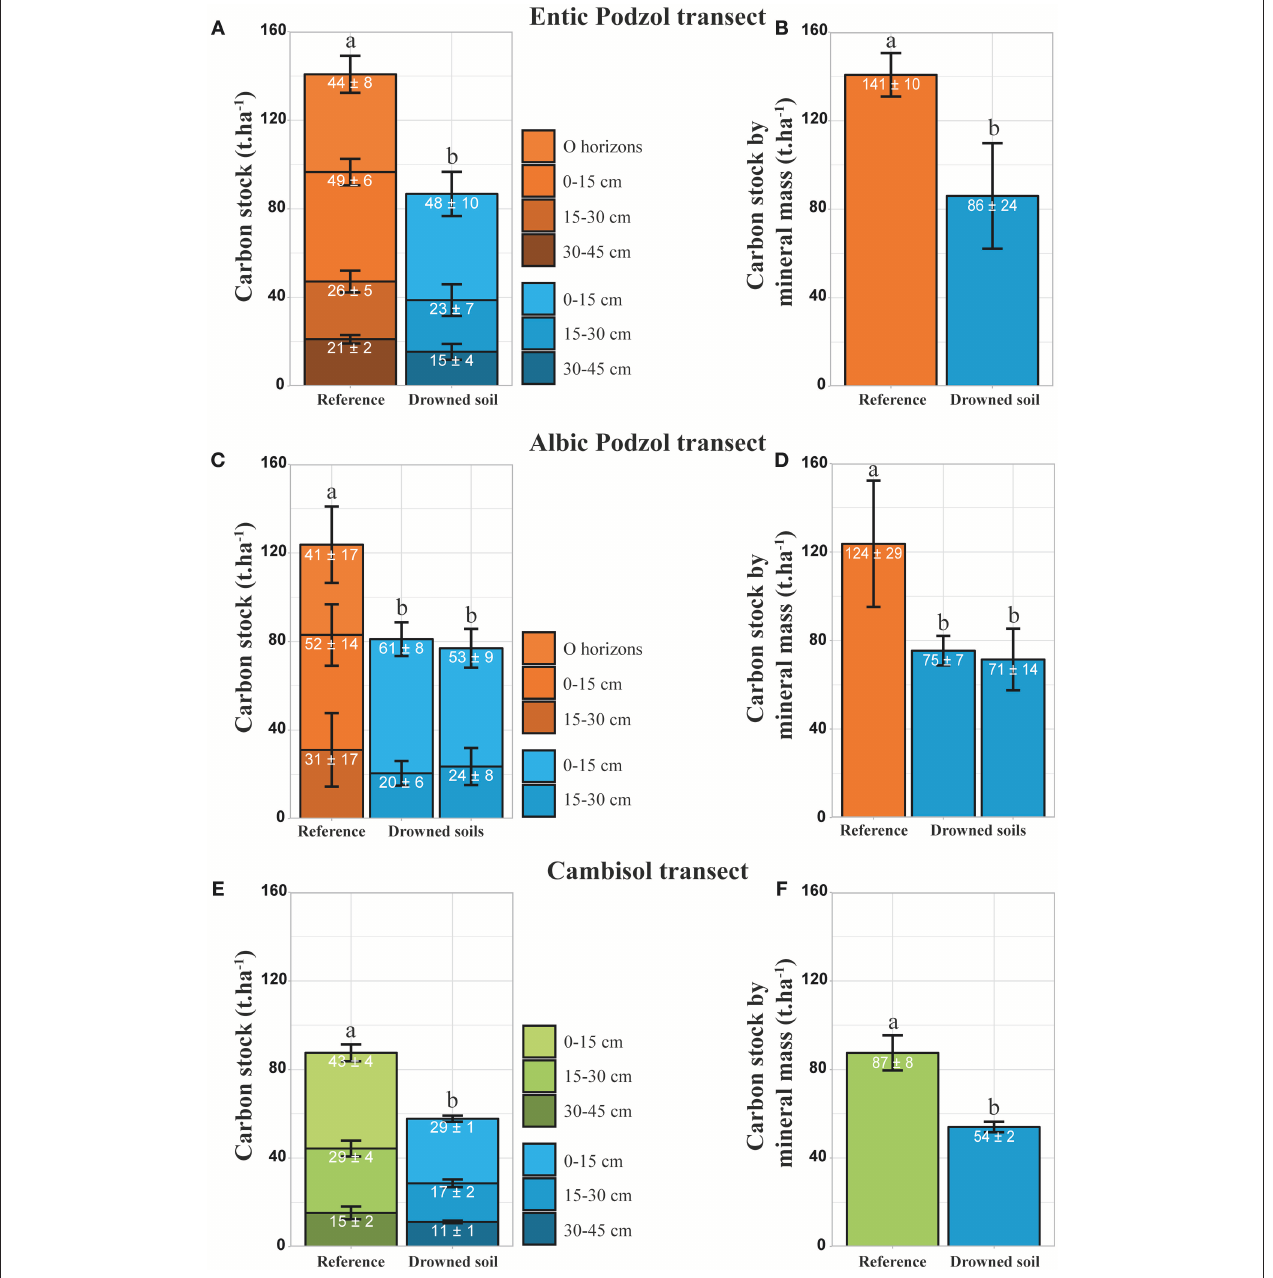
FIGURE 5 | (A,C,E) : Bar plots of the average total organic carbon stocks (t.ha − 1 ) by depth, down to 45cm for Entic Podzol and Cambisol and 30cm for Albic Podzol (see text). Error bars represent ± 1 sd. Average stock values at each depth are given ± 1 sd. (B,D,F) : Bar plots of average organic carbon stocks (t.ha − 1 ) calculated for a mass of mineral soil equivalent to the reference soil. Error bars represent ± 1 sd. Average stock values at each depth are given ± 1 sd. Statistical differences were calculated by transect using TukeyHSD test. Entic Podzol: p -values < 0.01. Albic Podzol: p -values < 0.01. Cambisol: p -values < 0.01.